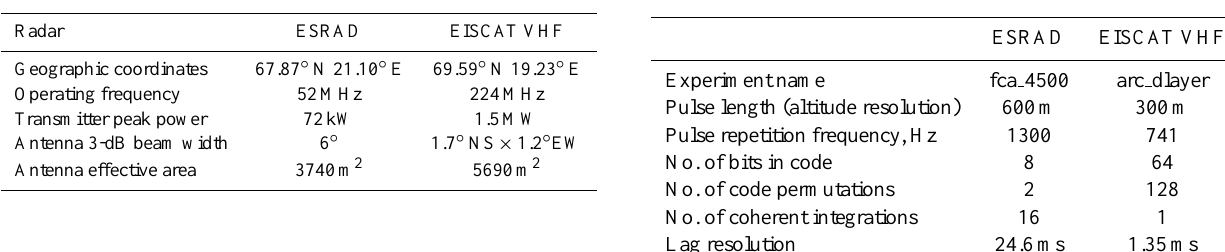
Table 1. Parameters of the radars. Table 2. Parameters of the